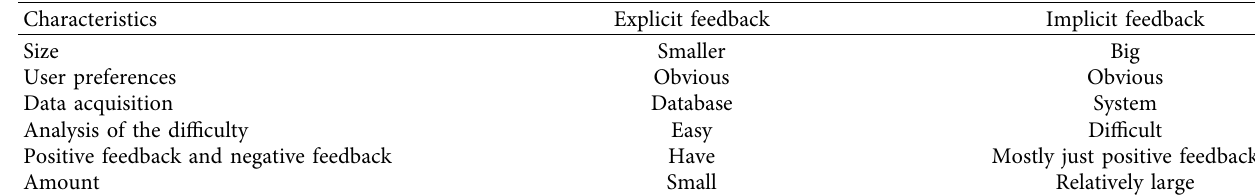
Table 2: Comparison of explicit and implicit feedback.